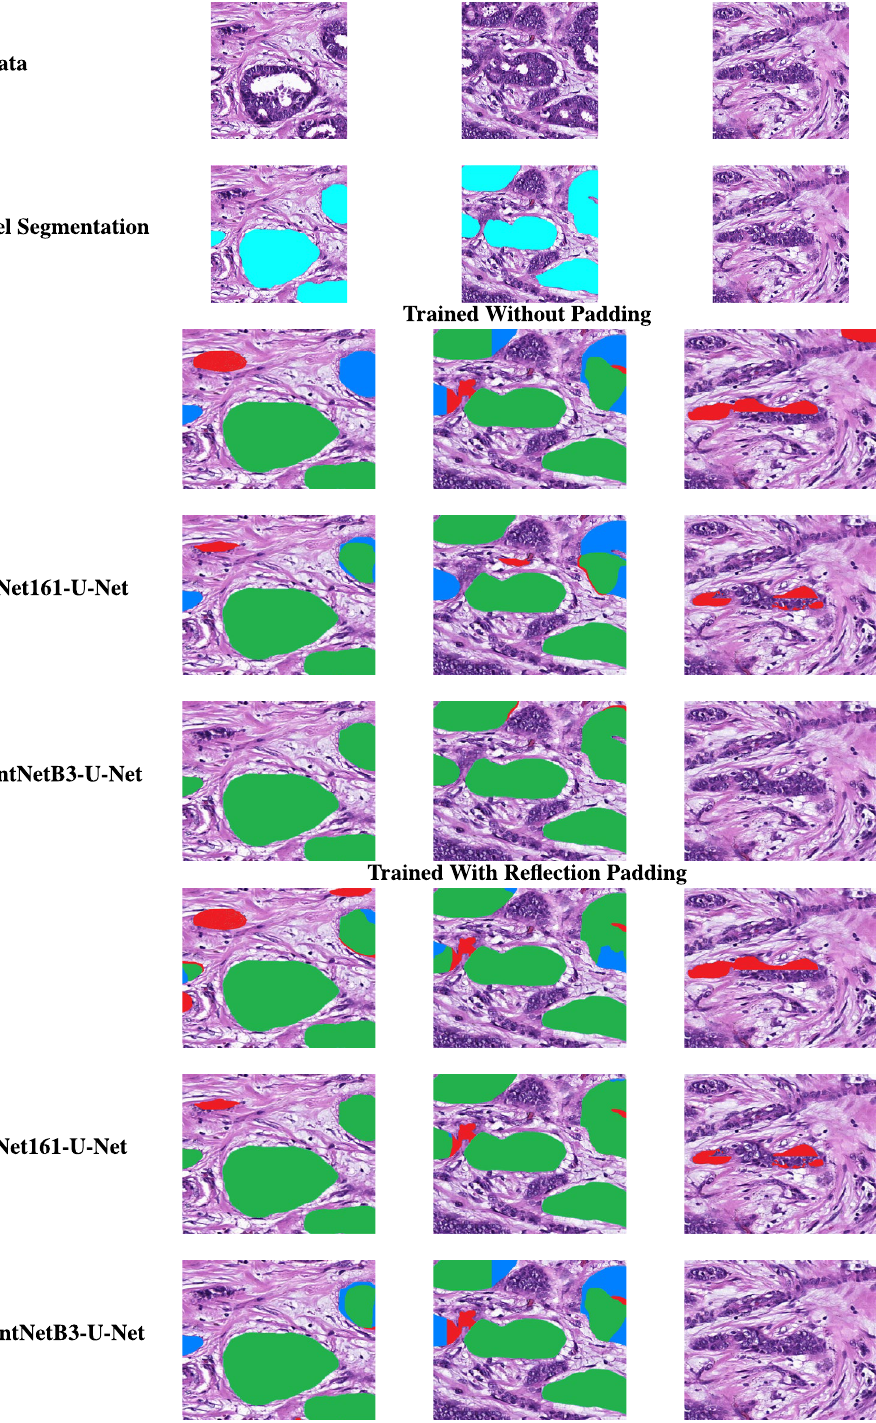
Figure 5. Qualitative segmentation results of the three deep learning segmentation models trained with and without Reflection padding. The segmentation results are shown as: Green, correct segmentation regions; Blue, non-segmented regions which must be segmented; Red, incorrectly segmented